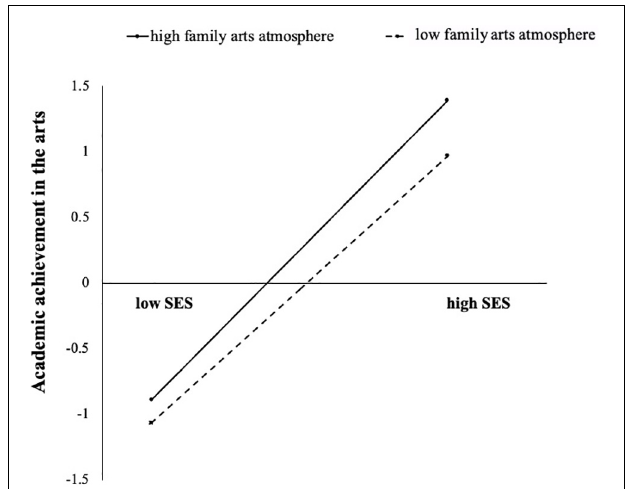
FIGURE 4 | Interaction between family SES and family arts atmosphere in predicting academic achievement in the